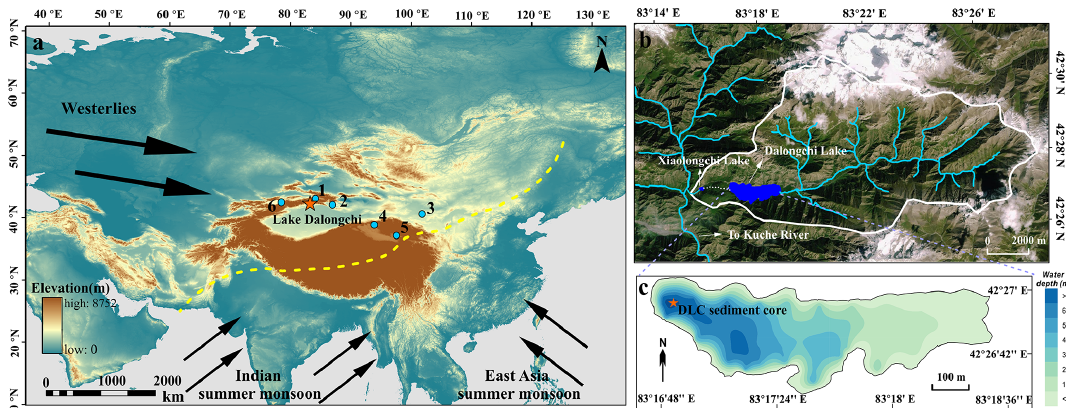
Figure 1. Maps of the study site. (a) Locations of Lake Dalongchi and other humidity records in arid Central Asia, mentioned in the text. Sites 1–6 denote the Bayanbuluk meteorological station, Lake Bosten (Chen et al., 2006), Badian Jaran Desert (Ma and Edmunds, 2006; Gates et al., 2008), Lake Sugan (He et al., 2013), Lake Gahai (He et al., 2013), and Lake Ala Kol (Rousseau et al., 2020), respectively. The dashed yellow line indicates the boundary of the modern Asian summer monsoon; the mid-latitude inland region on the western side of the modern Asia summer monsoon boundary line is arid central Asia (ACA) (Chen et al., 2010; F. Chen et al., 2019). The map was generated using ArcMap 10.2 software (ESRI, USA, http://www.esri.com, last access: 9 February 2020). (b) Watershed map of the study site. (c) Bathymetric contour map of Lake Dalongchi with the coring site.